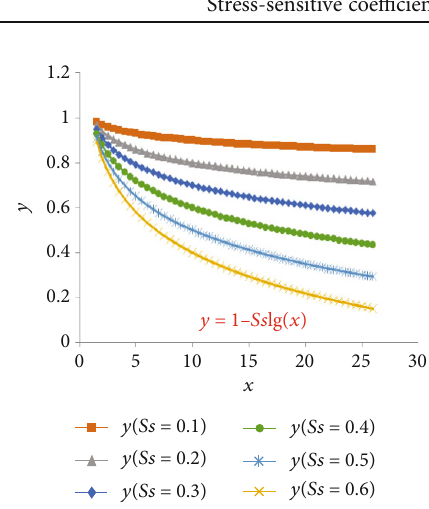
Figure 3: Stress-sensitive coe ffi cient